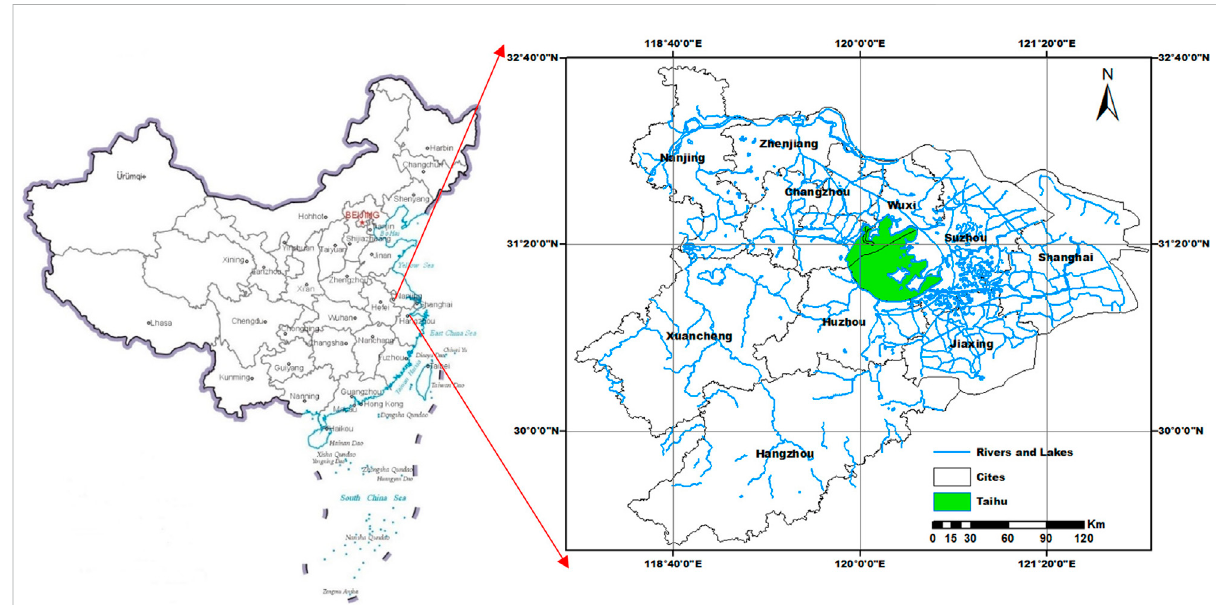
FIGURE 1 Location of Taihu Basin, China.jpg. Note: The map of China was downloaded from http://bzdt.ch.mnr.gov.cn/. Supervised by the Ministry of Natural Resources of the People ’ s Republic of China. Drawing review number is GS (2019)1651. Map of Taihu generated by ArcGIS 10.5. URL link: